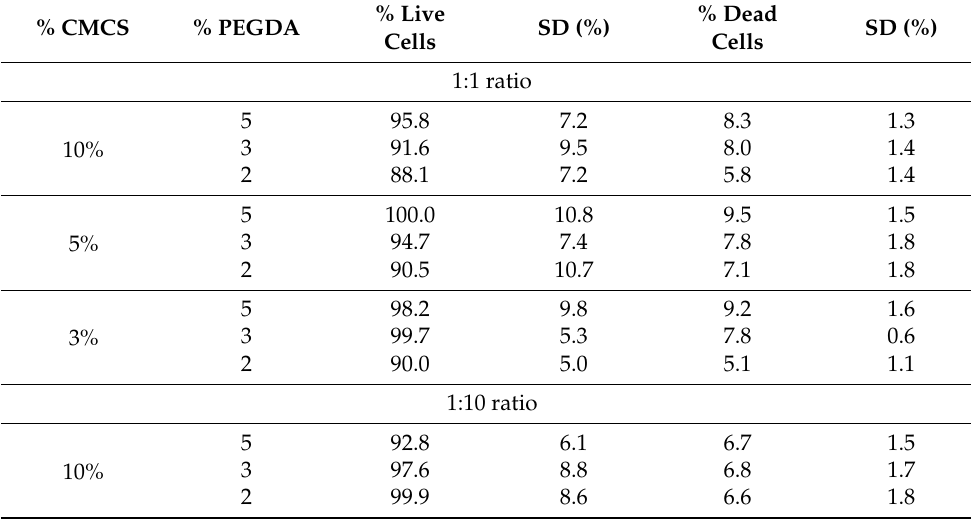
Figure 6. Fluorescence microscopy of live (stained with calcein AM) and dead (stained with ethidium homodimer) human fibroblast cell lines treated with hydrogel (3% CMCS and 3% PEGDA) at various dilutions for 48 h. Observations were made at room temperature (~25 ◦ C). Table 1. Cell viability at various concentrations of the gel extracts diluted with the pure medium in proportions of 1:1, 1:10, and